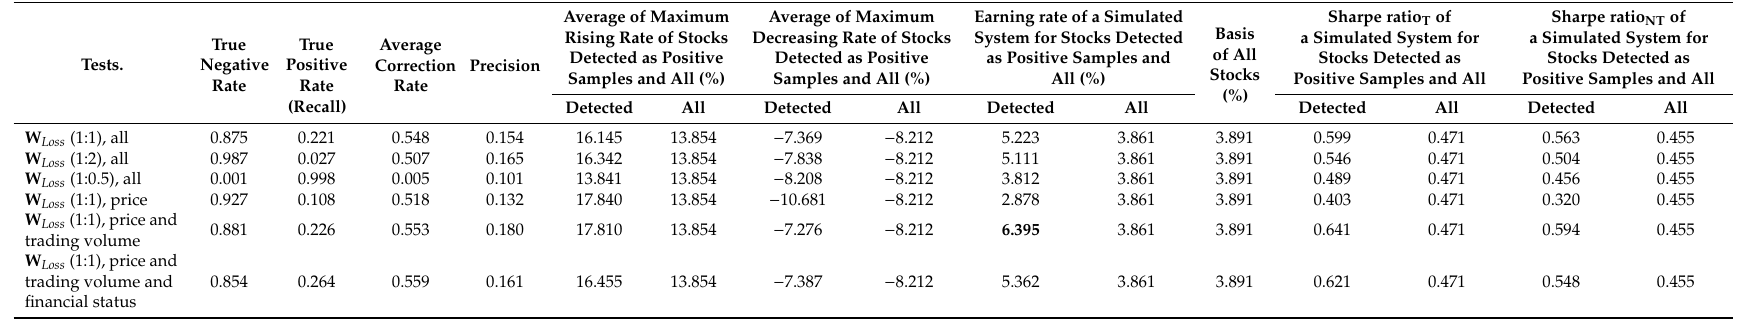
Table 7. Constant threshold-based stock classification considering historical volatility using di ff erent W Loss values and di ff erent features (all: all features; price: price-related features; trading volume: trading volume feature; financial status: company financial status-related features).